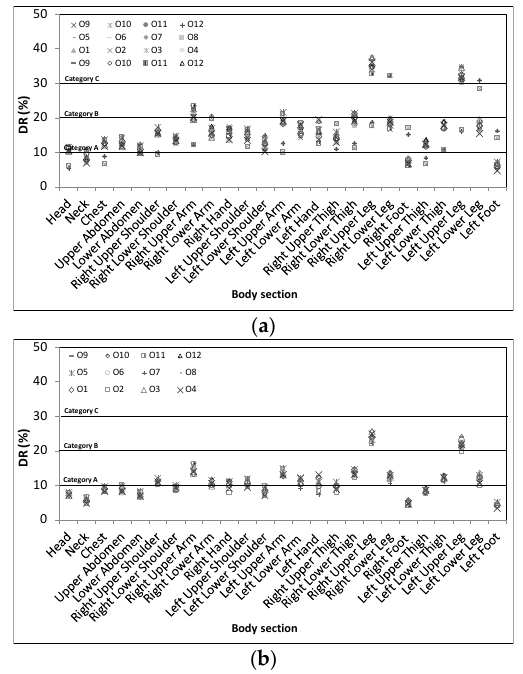
Figure 19. Mean DR value around the 25 human body sections of 12 occupants, for an inlet air temperature of ( a ) 20 °C and ( b ) 24 °C.